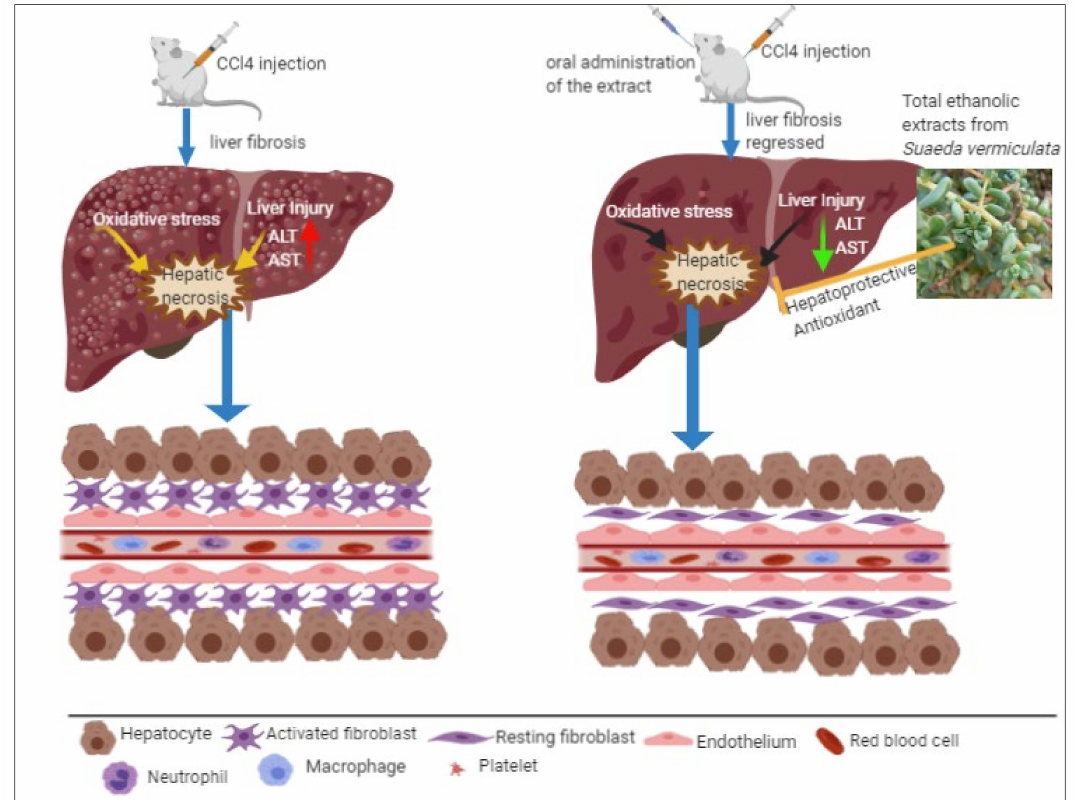
Figure 6. Sketch representing the role of the plant extract in liver